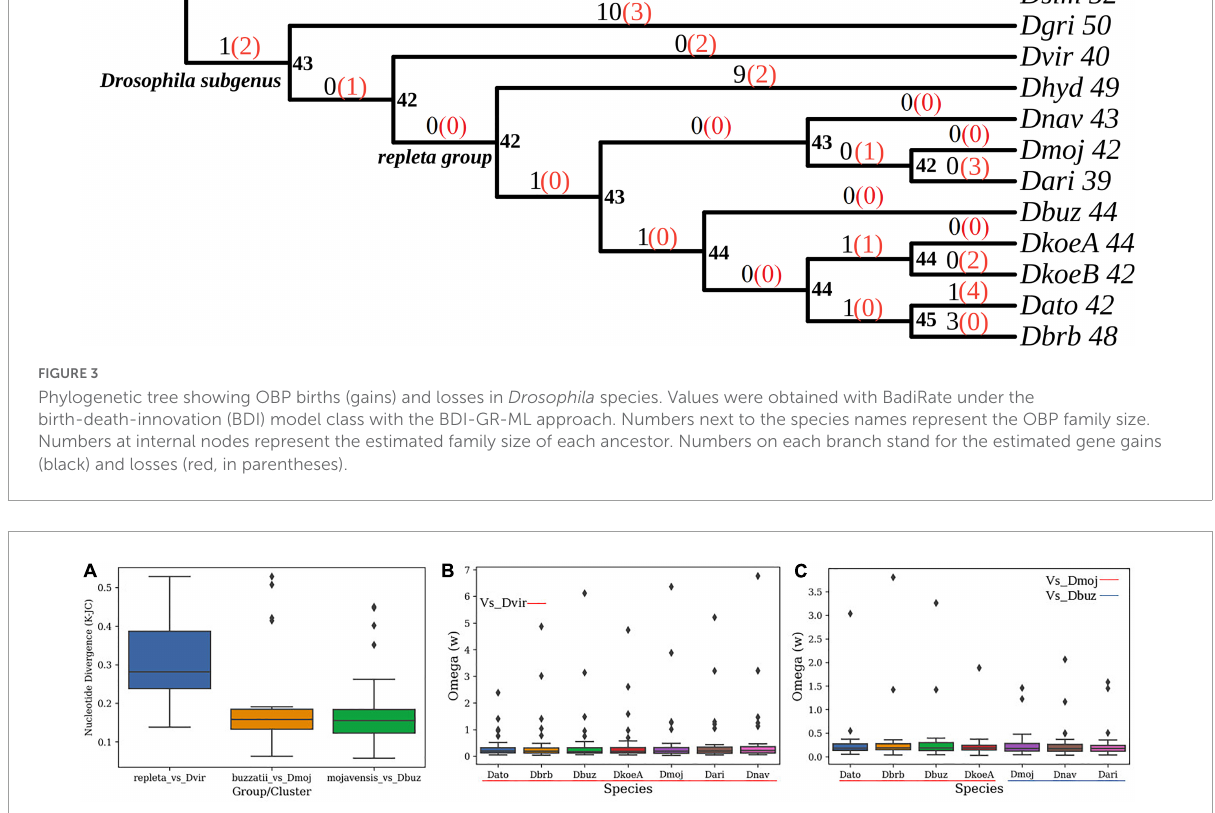
FIGURE4 Distribution and patterns of nucleotide divergence (K-JC) for OBP genes. (A) Nucleotide divergence of the repleta group, buzzatii cluster, and mojavensis cluster. (B) ω -values in pairwise comparisons between mulleri subgroup species and D. virilis , (C) ω -values in pairwise comparison between species of the buzzatii cluster and D. mojavensis , and between species of the mojavensis cluster and D. buzzatii